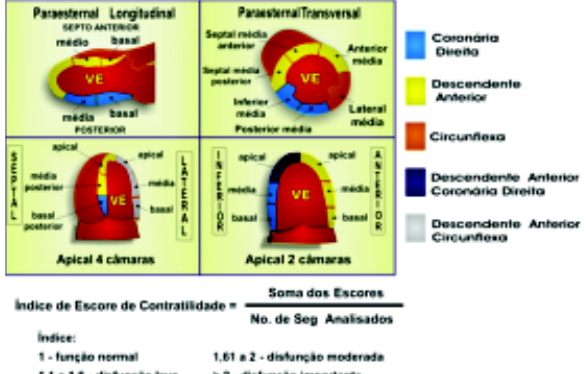
Fig. 2 – Divisão Segmentar do Ventrículo